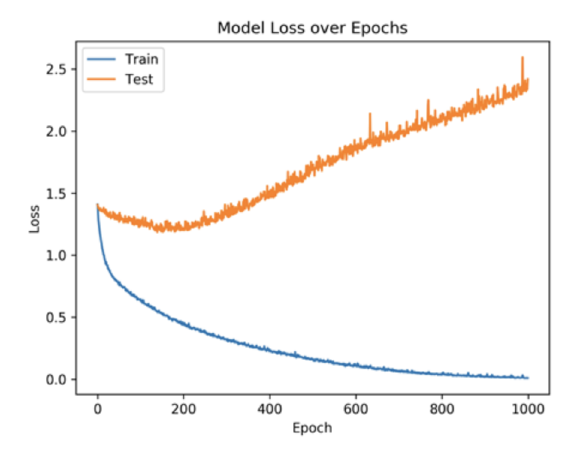
Figure 10. Neural network performance over epochs.